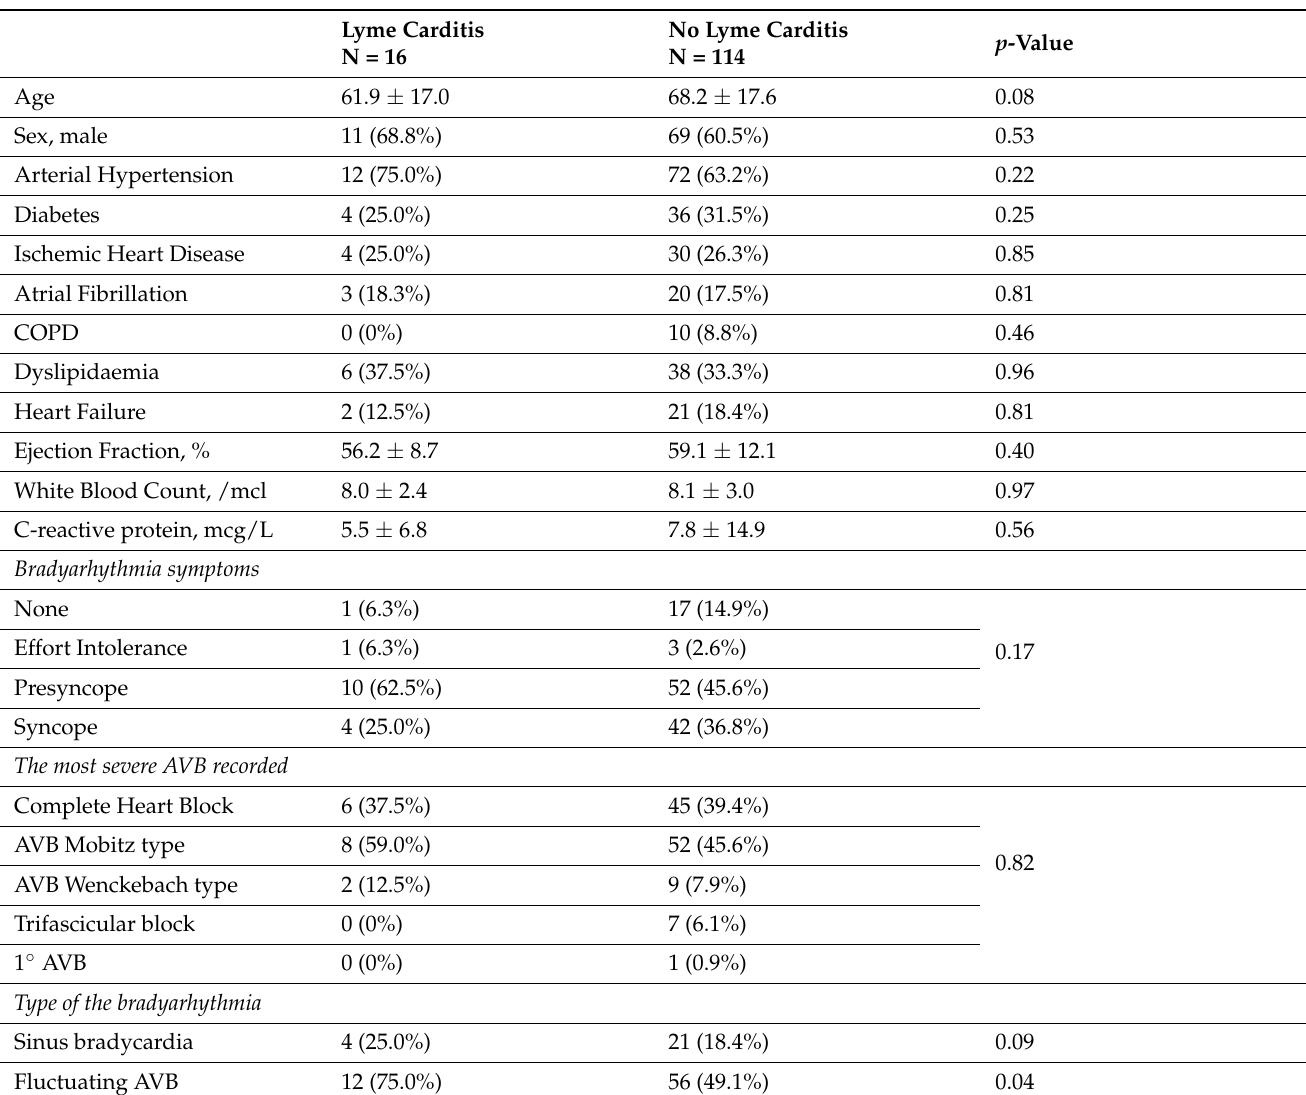
Table 3. Clinical